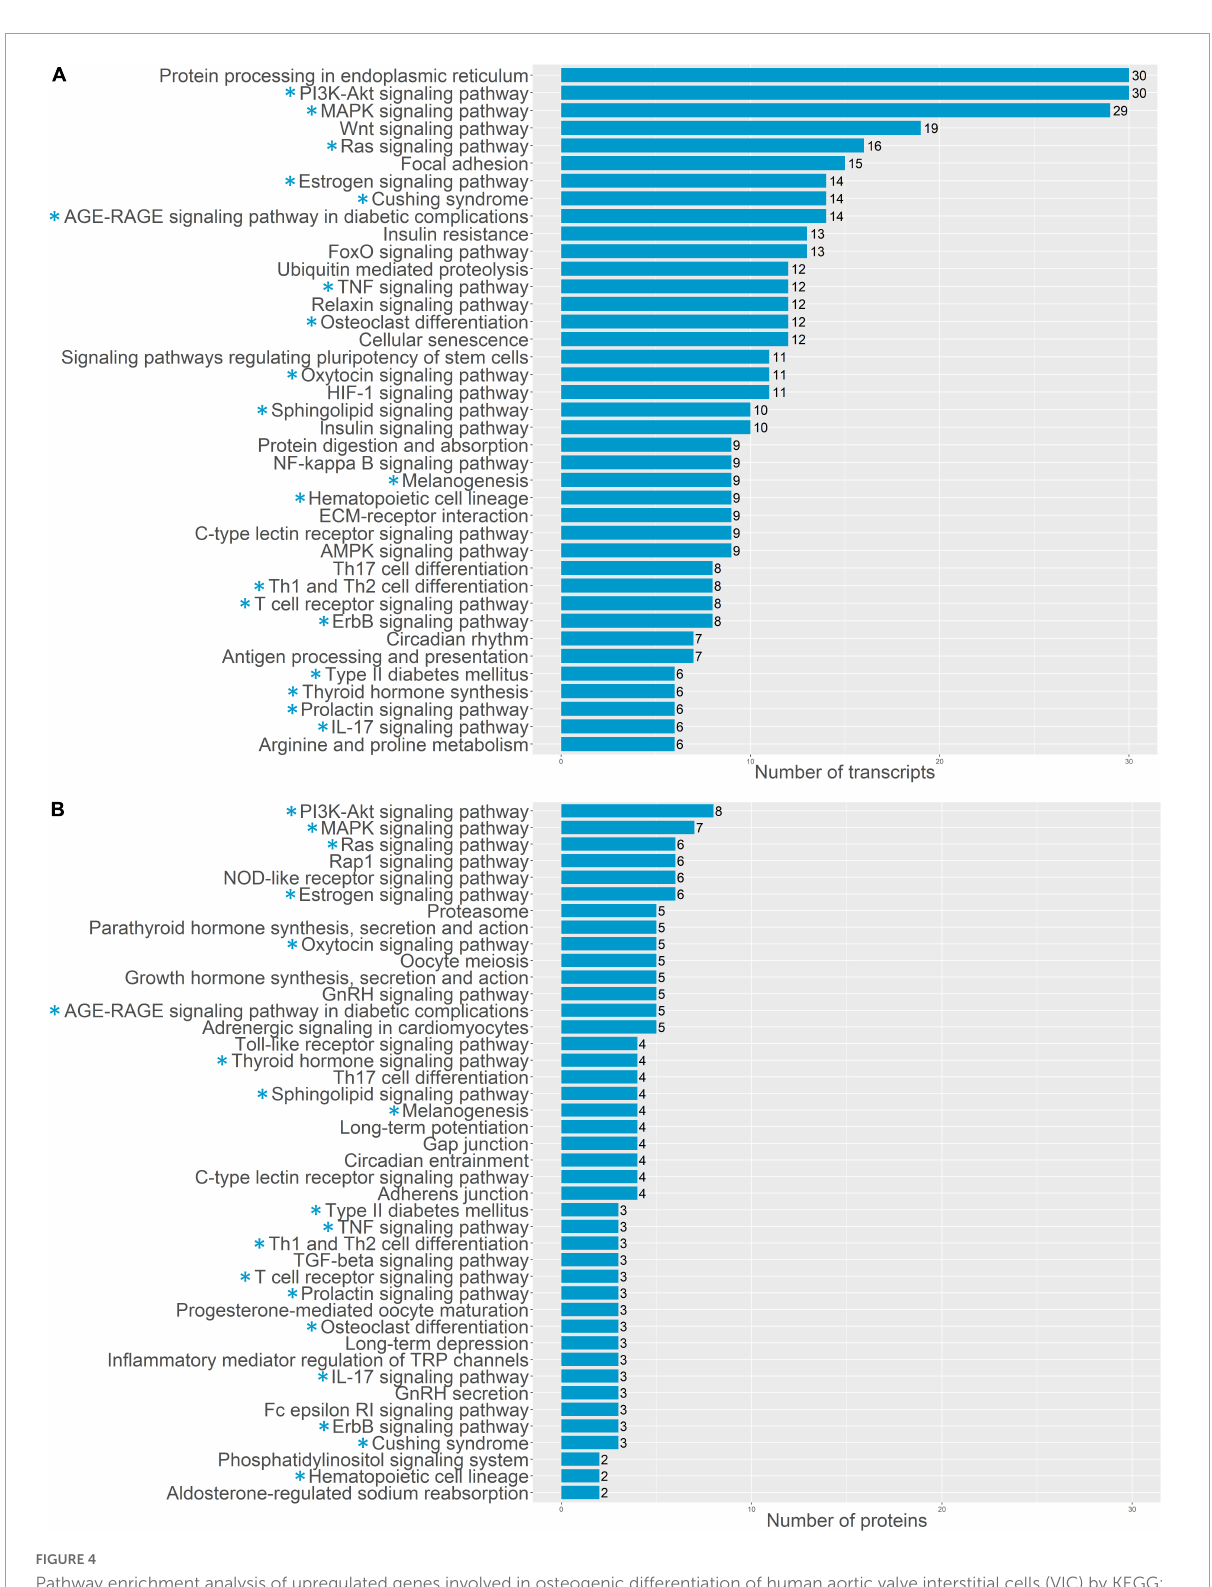
FIGURE4 Pathway enrichment analysis of upregulated genes involved in osteogenic differentiation of human aortic valve interstitial cells (VIC) by KEGG: biological processes database. Abscissa axis represents biological processes associated with VIC osteogenic differentiation in early timepoint by RNA-seq transcriptomics data (A) or later timepoint by shotgun proteomics data (B) ; ordinate axis represents number of identified differentially expressed transcripts (A) or proteins (B) enriched in corresponding biological process. Asterisk marked KEGG (*): biological processes enriched in both proteomics and transcriptomics